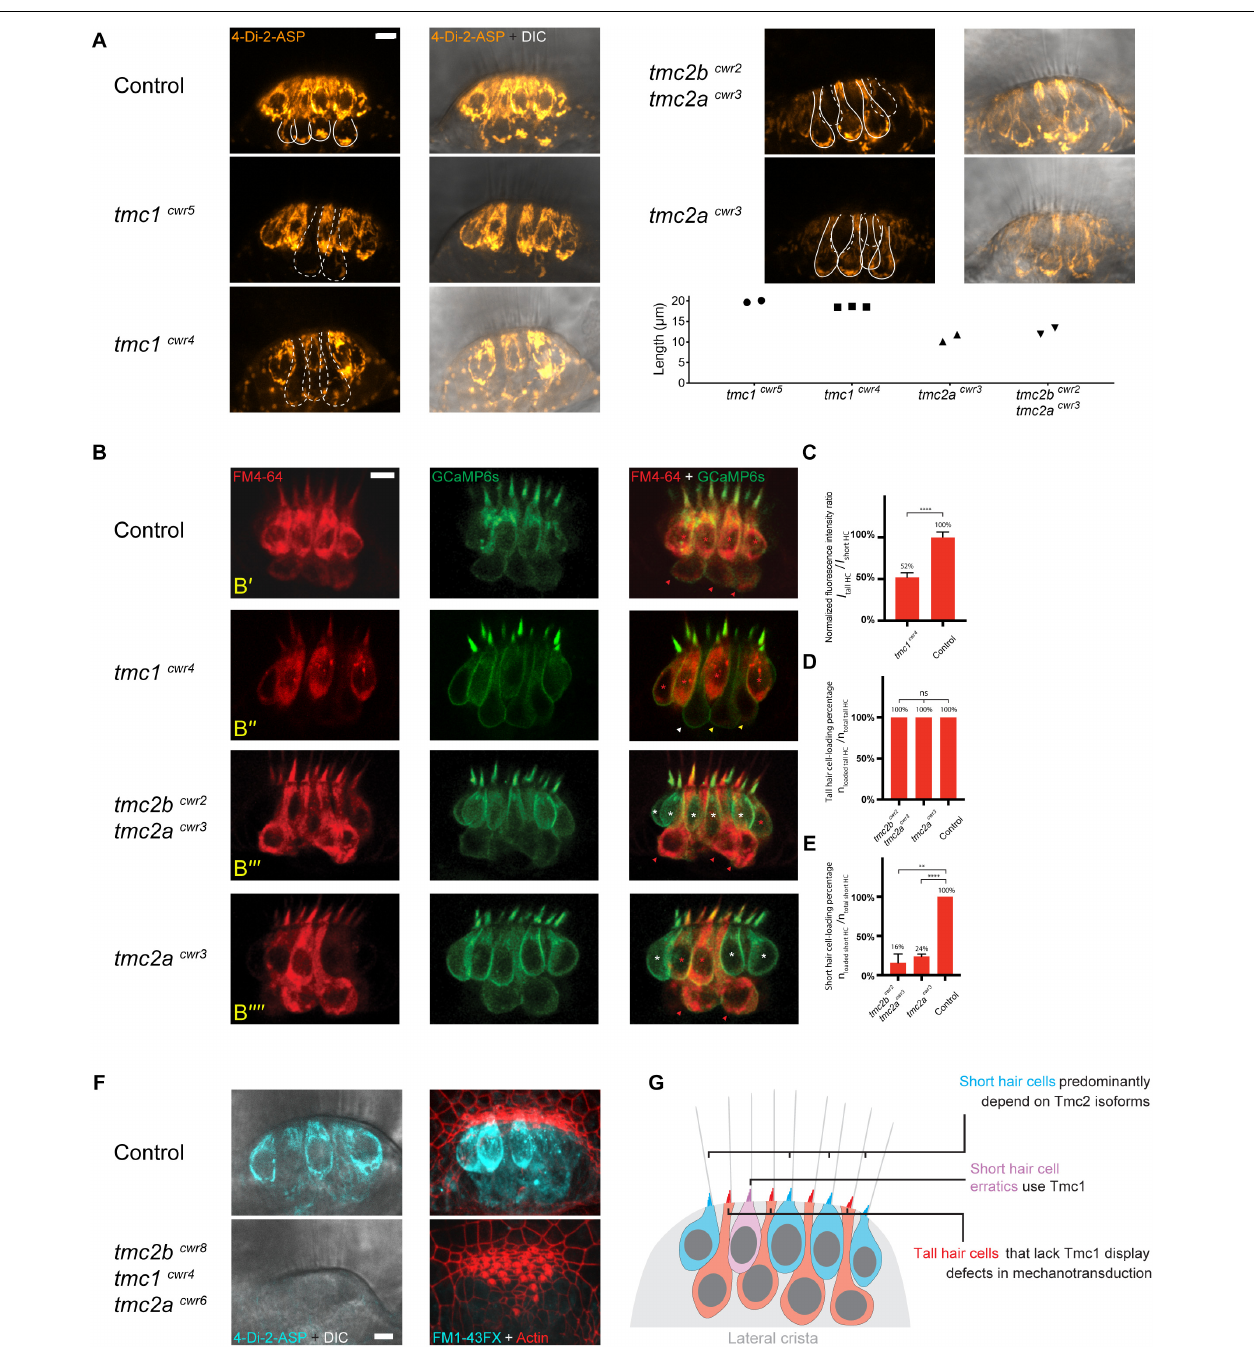
FIGURE 2 | Tall and short hair cells of the lateral crista display biases for Tmc proteins in mechanotransduction. (A) Representative confocal images of 4-Di-2-ASP (orange) dye uptake assays showing differential dependencies of tall and short hair cells on Tmc proteins in the lateral cristae of 7-dpf larvae. Solid lines outline tall hair cells with 4-Di-2-ASP uptake in a wild-type sibling, a tmc2a cwr3 single mutant, and a tmc2b cwr2 tmc2a cwr3 double mutant. In each wild-type tall hair cell, there is an accumulation of dye near the cell’s base. The dashed lines outline tall hair cells with diminished 4-Di-2-ASP uptake in the tmc1 cwr5 single mutant and the tmc1 cwr4 single mutant or short hair cells with no or little 4-Di-2-ASP uptake in the tmc2b cwr2 tmc2a cwr3 double mutant and the tmc2a cwr3 single mutant. Graph of lengths of hair cells that have diminished 4-Di-2-ASP uptake. Each data point represents a single cell’s length and associated genotype. Cells associated with each data point are shown in confocal images with dashed outlines. (B) Representative confocal images of FM 4–64 (red) uptake assays for a heterozygous sibling control ( tmc2b cwr2 / + tmc2a cwr3 / + , B’ ), a tmc1 cwr4 single mutant (B”) , a tmc2b cwr2 tmc2a cwr3 double mutant (B”’) , and a tmc2a cwr3 single mutant (B””) , each at 7-dpf. The lateral crista hair cells express GCaMP6s-CAAX (green), making each cell apparent. The red or white asterisks mark the short hair cells with or without FM4-64 loading, respectively. Red, yellow, or white arrowheads mark tall hair cells with normal, reduced, or no apparent FM4-64 dye loading, respectively. Red asterisk